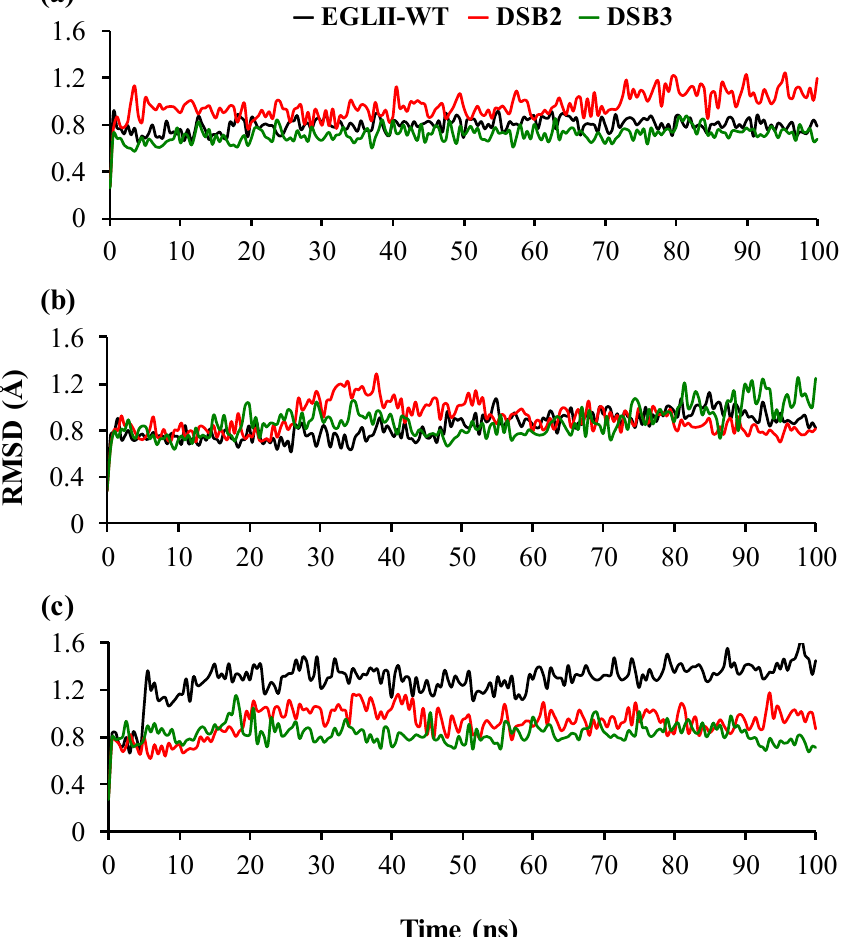
Figure 5. The structural stability of the EGLII forms based on RMSD: ( a,b ) At 26.85 and 70 °C, the RMSD of the backbone indicated that the DSB2 and DSB3 variants and EGLII-wt had similar structural stabilities. ( c ) At 80 °C, the RMSD of the backbone of EGLII-wt showed an instability, whereas the structures of the DSB2 and DSB3 variants remained stable.